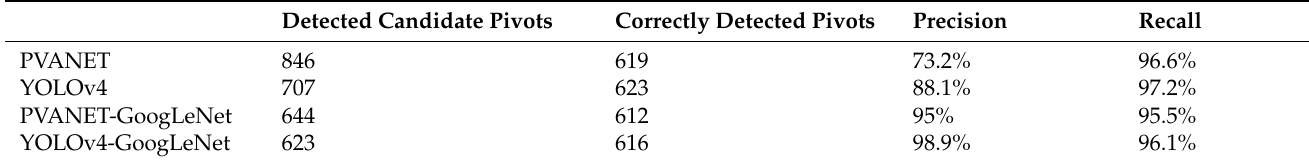
Table 2. Comparison of PVANET and